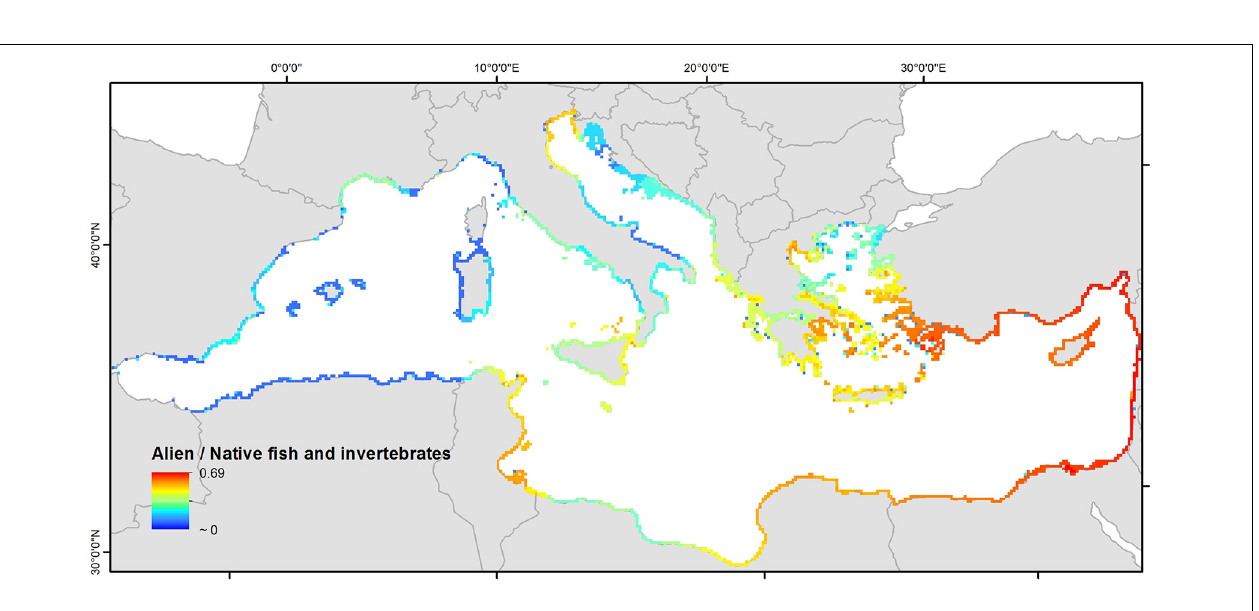
invertebrates and thus the absolute values of this indicator appear elevated. However, this is not expected to affect the spatial patterns depicted in this